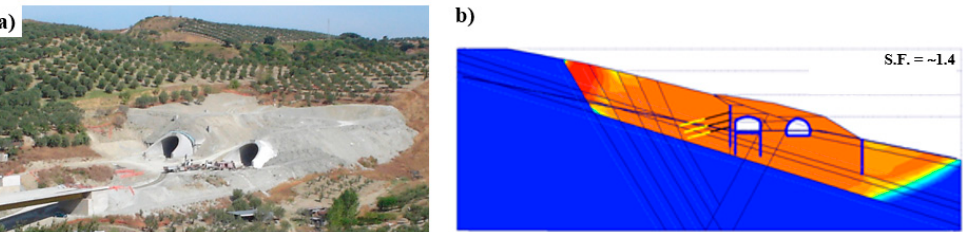
Figure 8. ( a ) Picture of the Baldaia I southern portal after implementation of the remedial measures; ( b ) FEM analysis result: ϕ -c reduction method after the remedial measures.